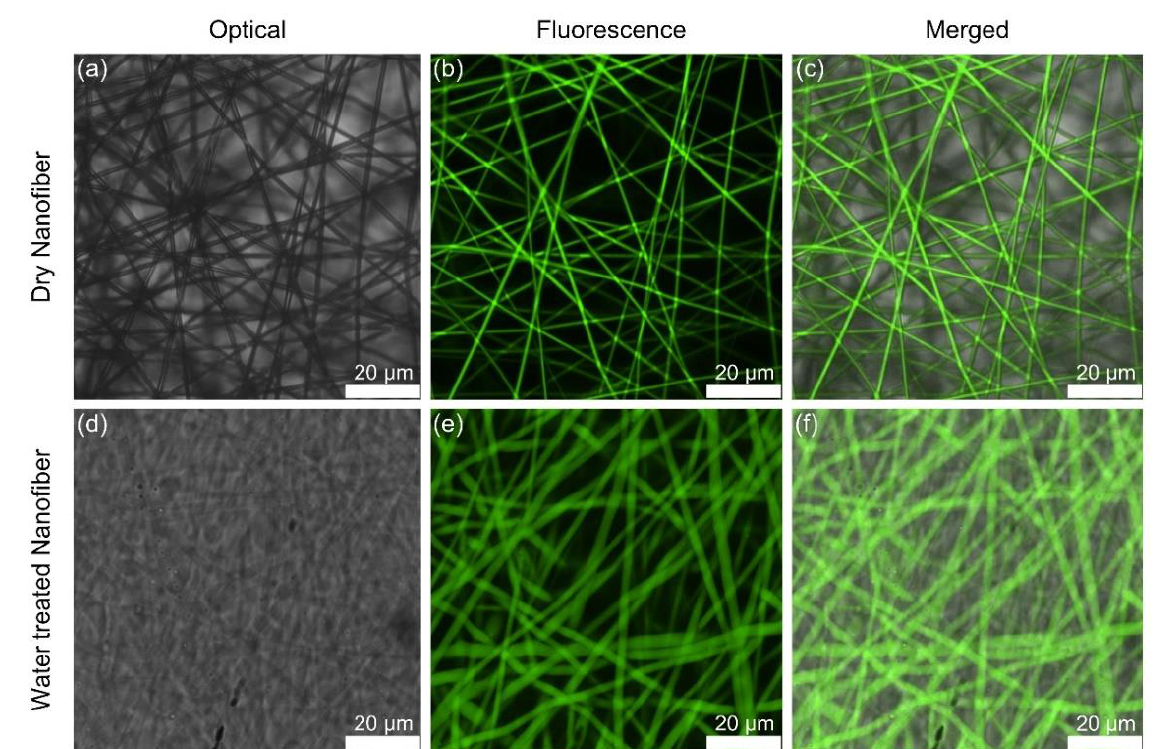
Figure 3. CLSM images of the nanofiber containing fluorescein. ( a – c ) Original dry nanofibers. ( d – f ) Water-treated nanofibers. The crosslinking of PNIPAM and OpePOSS through heat treatment at 160 ◦ C is a promising method for the high and long-time stability of nanofibers in an aqueous